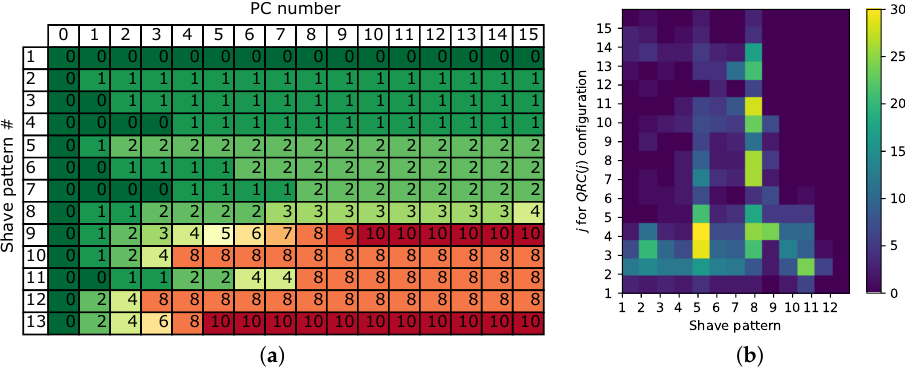
Figure 5. Shave bit patterns and their results when compressing. ( a ) Shave patterns and how many bits are shaved on each PC. For each shave pattern and each PC, the number of bits removed when quantizing are shown. Note that the number always increases since the PCs contain progressively less information; ( b ) QRC configuration vs. different bit shave